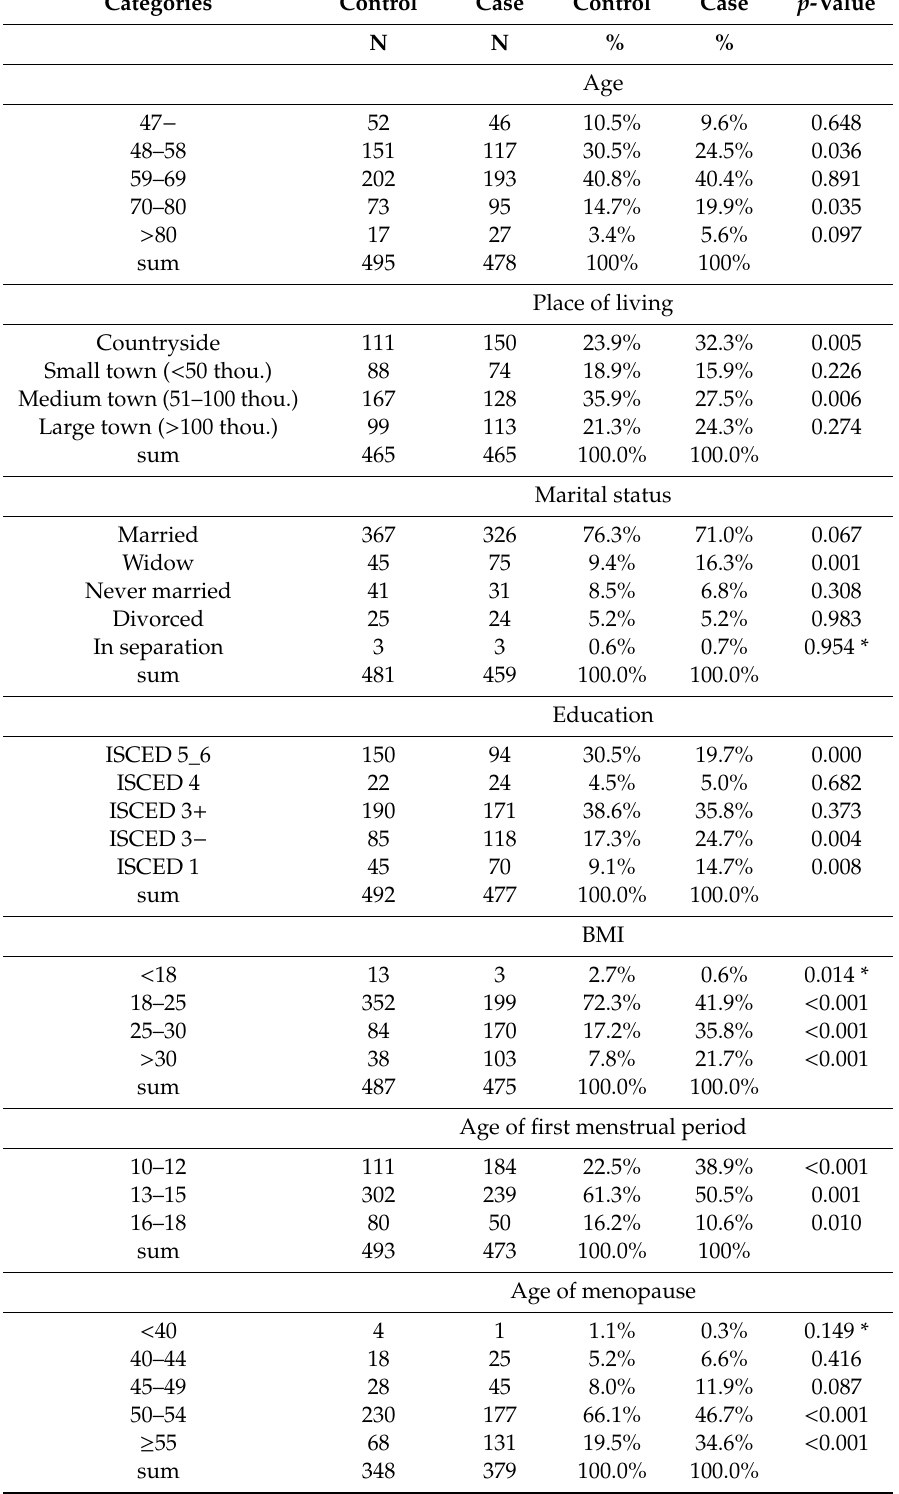
Table 2. Characteristics of the cases and control groups